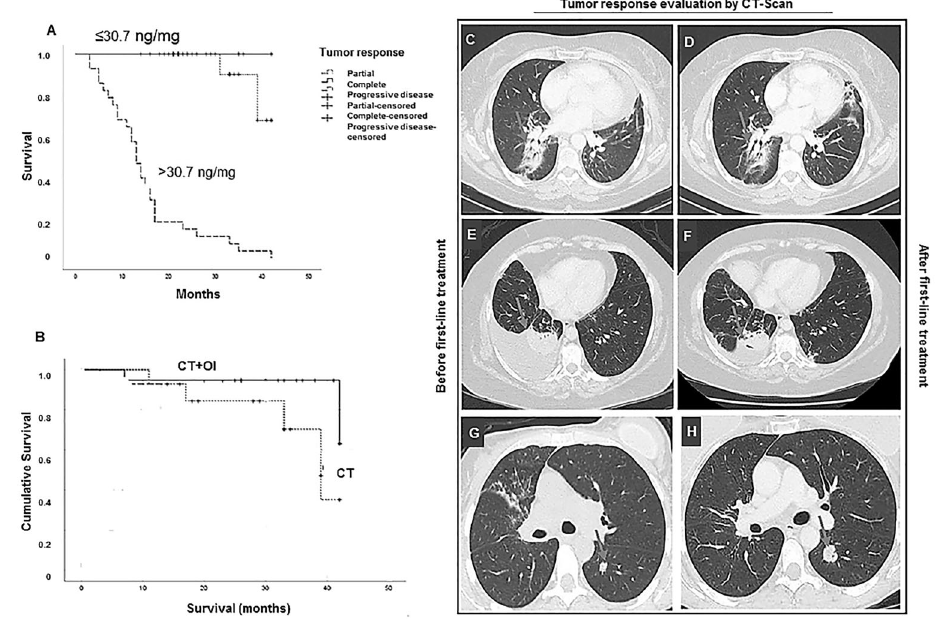
Figure 3. Kaplan-Meier plots of survival probability vs follow-up time in months in patients with tumor response evaluation con fi rmed by computed tomography scan (CT-scan), after fi rst line-therapy. A , The group with hyaluronan (HA) p 30.7 ng/mg in 7% NaCl in sputum appears as the top curve and the group with HA 4 30.7 ng/mg in sputum appears as the bottom curve. B , The group of patients treated with systemic chemotherapy + immunotherapy (CT + IO) appears as the top curve and the group treated only with chemotherapy (CT) appears as the bottom curve. C – H, The images show the tumor response evaluation by CT-scan after fi rst-line therapy. C and D , Patient with stable disease, E and F patient with partial response, and G and H , patient with progressive disease.